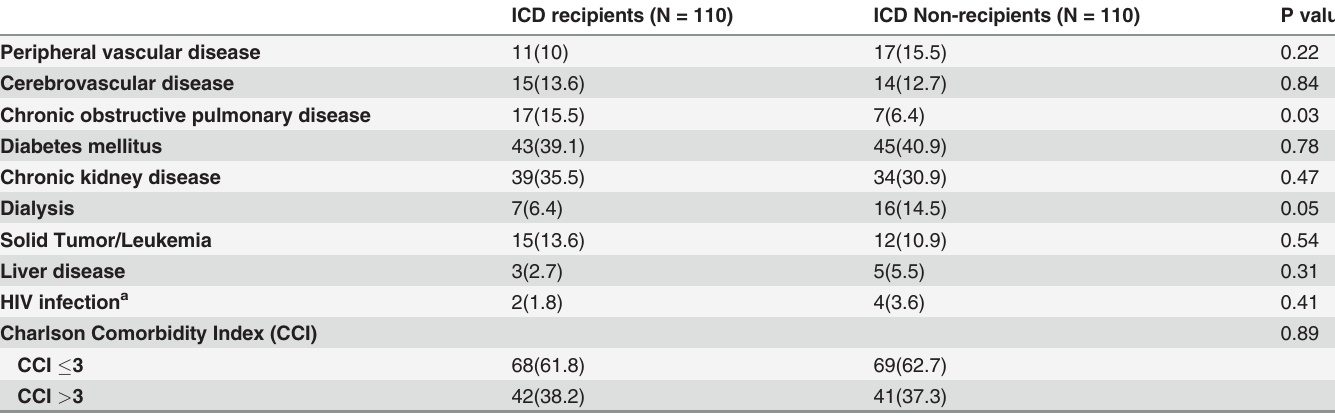
Table 3. Comorbidity Data of ICD Recipients versus